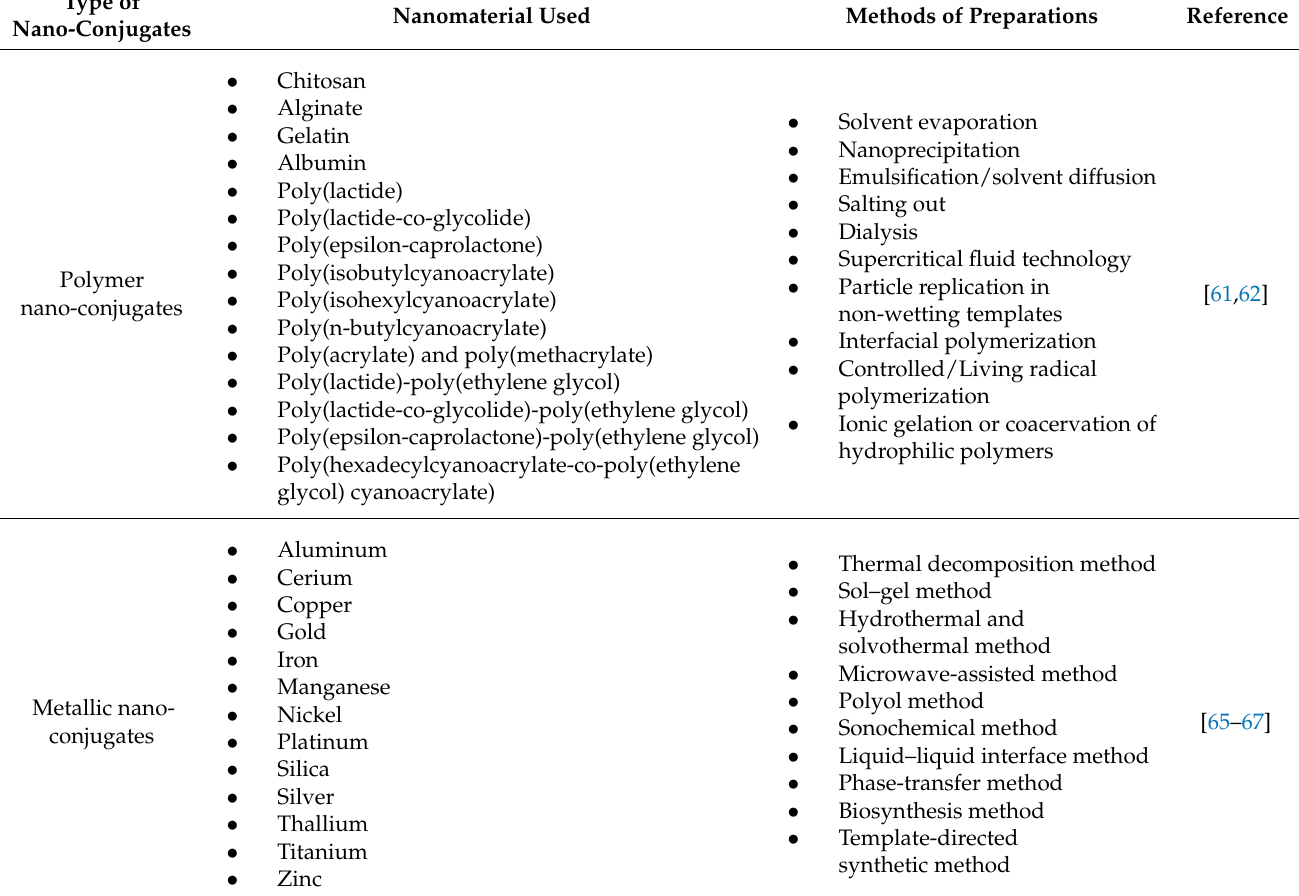
Table 2. Nanomaterials used and methods of preparations of polymer and metallic nano-conjugates. Type of Nanomaterial Used Methods of